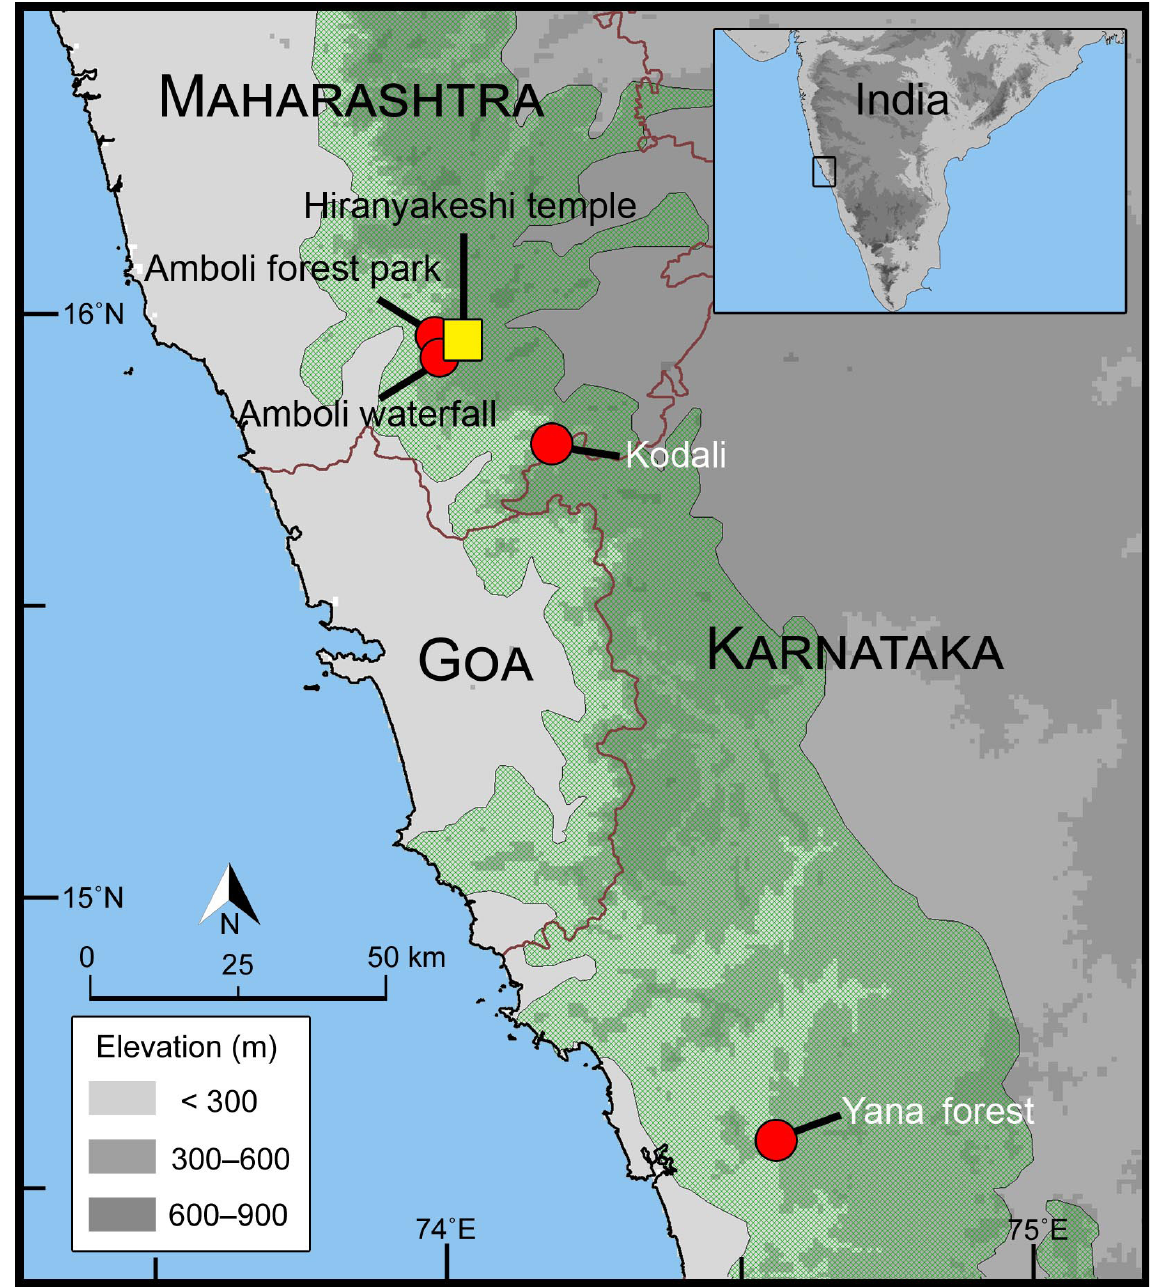
Fig. 1. Distribution of Varadia amboliensis Bhosale, Thackeray, Muley & Raheem gen. et sp. nov. (coloured symbols) in the Western Ghats (green shading; sensu Irfan-Ullah & Davande 2008). The yellow square indicates the type locality of the new species and the red circles are the other